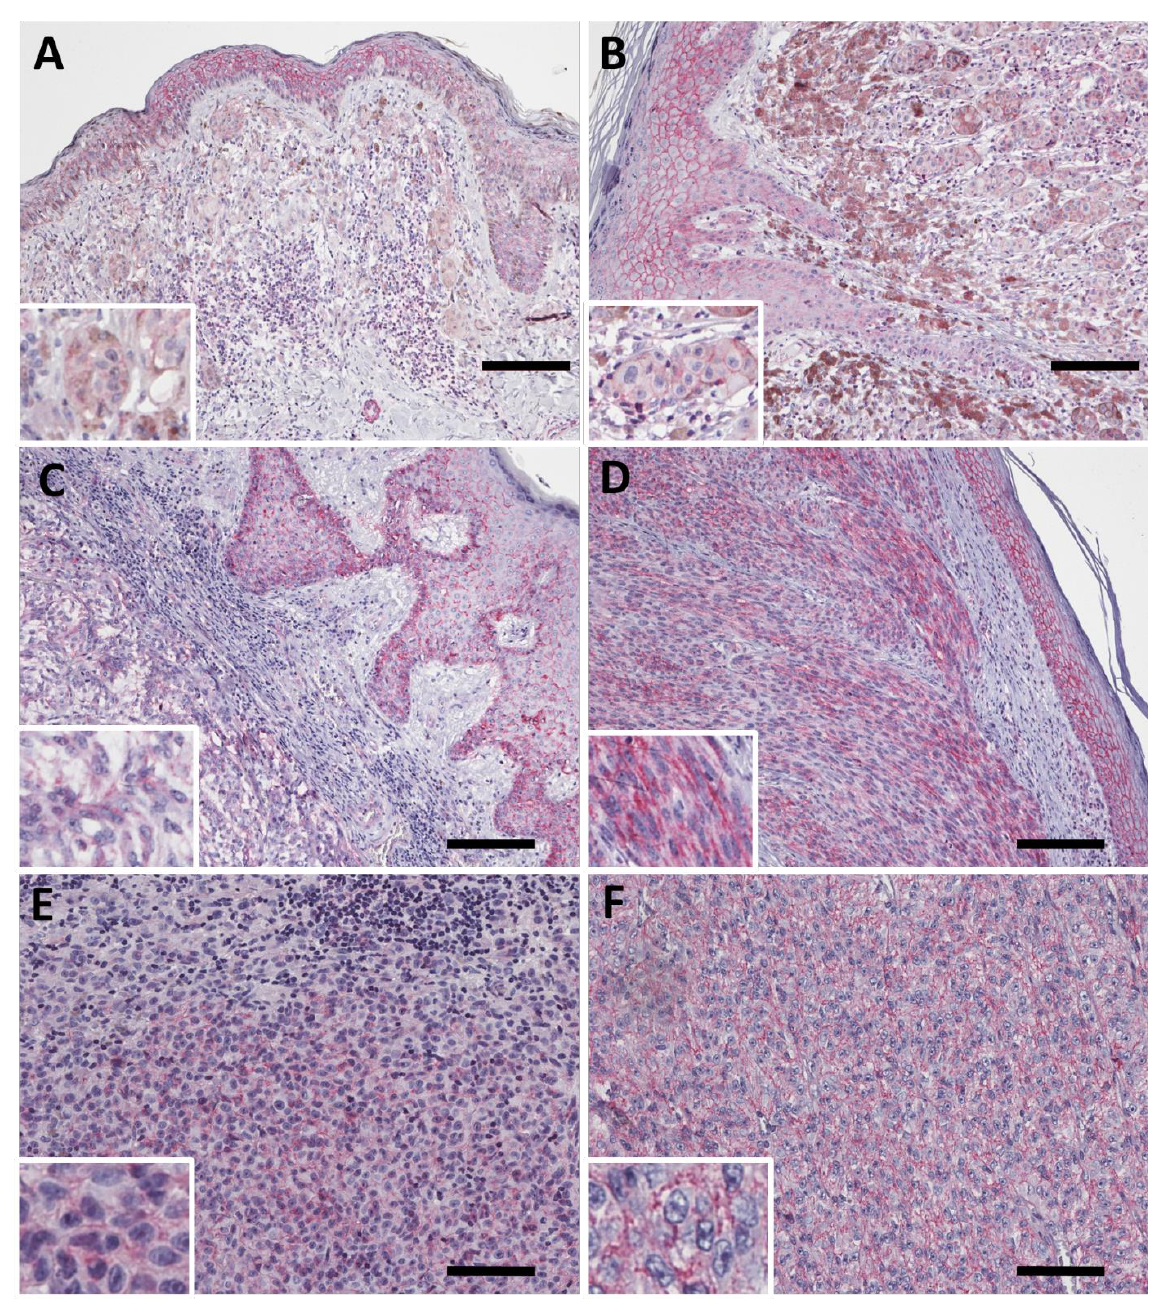
Figure 3. Representative images of PMCA4b expression in human primary melanoma. ( A ) Weak but clear plasma membrane-specific PMCA4b expression in cutaneous melanoma. ( B , C ) Intermediate staining intensity in epitheloid ( B ) and mixed morphology ( C ). ( D ) High PMCA4b expression in a cutaneous melanoma with spindle cell morphology. ( E , F ) Plasma membrane specific PMCA4b expression in conjunctival ( E ) and choroidal ( F ) melanoma. Scale bars: ( A – D ): 100 µm; E-F: 50 µm. The characteristic plasma membrane specific staining is present both in epitheloid